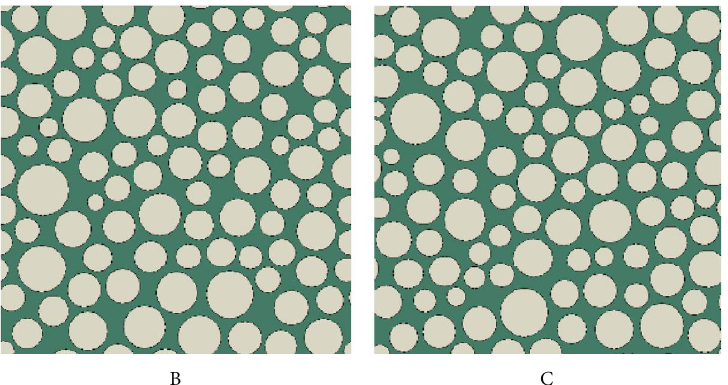
Figure 21: Another two realizations for Af equals to 60% and RVE size equals to 1000 μ m (realization in Figure 1(a) is marked as